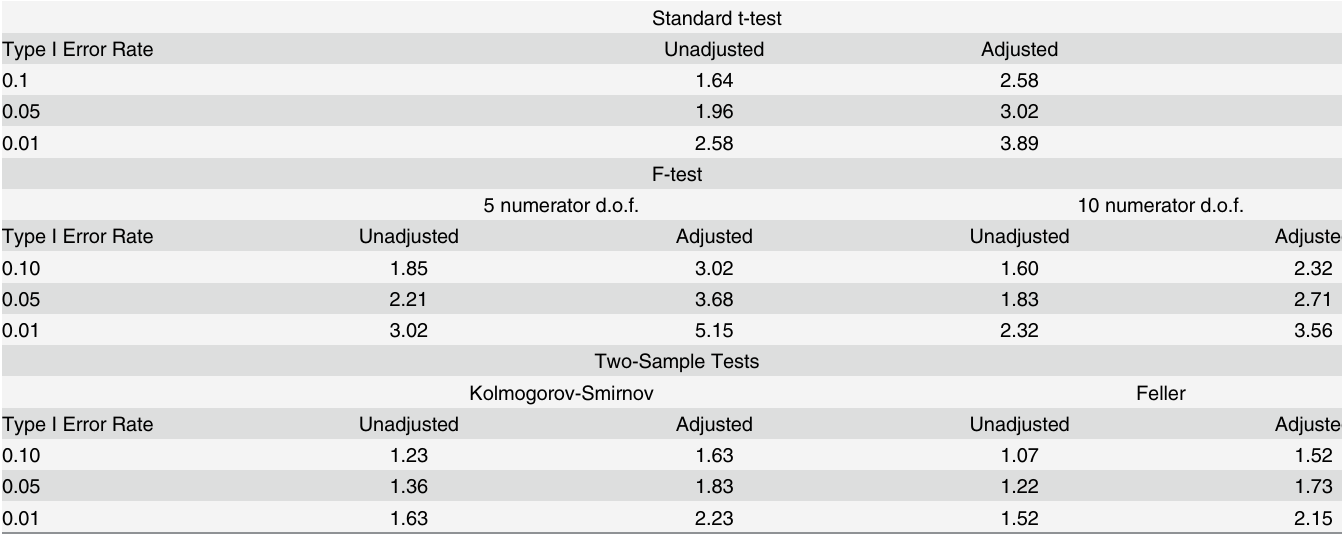
Table 1. Unadjusted and Adjusted Critical Values, Selected Testing Procedures.